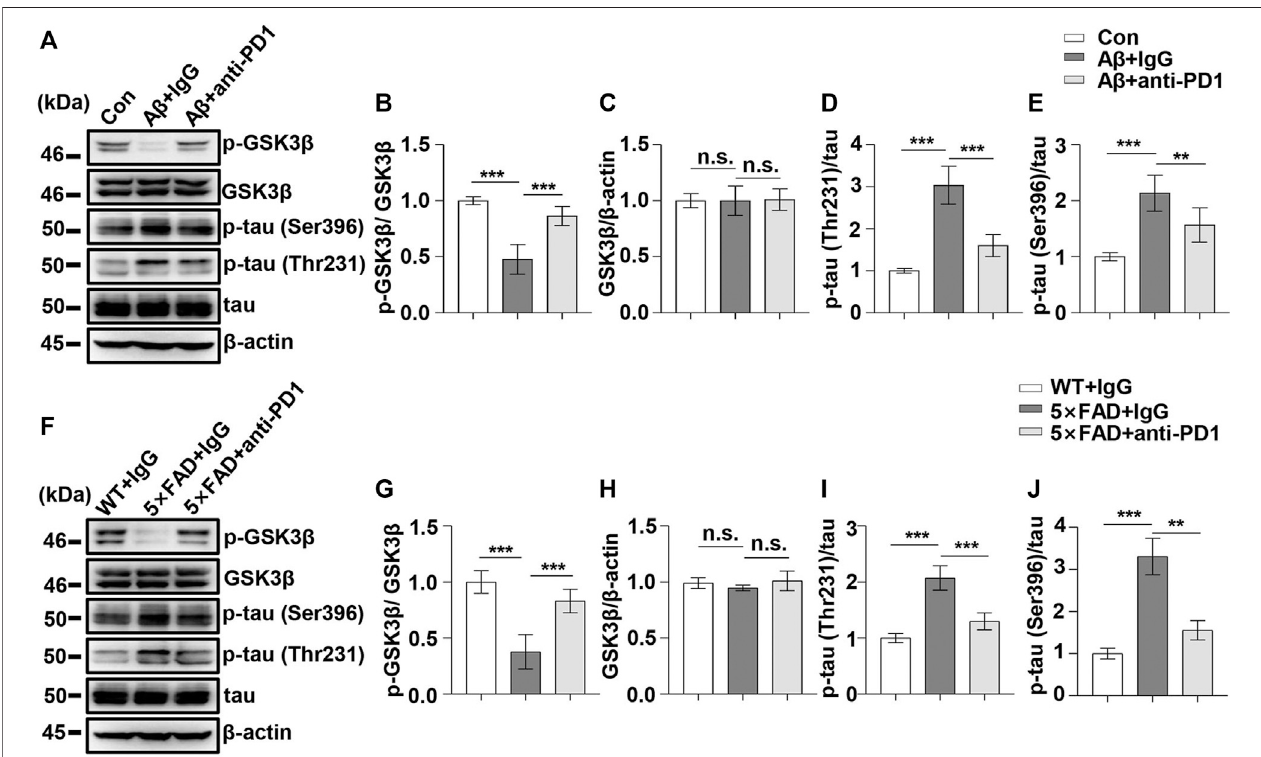
FIGURE5| PD1blockadereducedGSK3 β activityandtauhyperphosphorylationinADmousemodels.WTmice(C57BL/6,maleandfemale,aged2 – 3 months,n (cid:2) 10/group) were treated with A β 42, and then with anti-PD1 or control hamster IgG; after 12 days, the brain tissues were harvested. (A – E) PD1 blockade reduced GSK3 β activity and tau hyperphosphorylation. Hippocampal tissue lysates were subjected to western blotting with the anti- β -actin, anti-pGSK3 β (Ser9), anti-GSK3 β , anti-p-tau(Thr231),anti-p-tau(Ser396),andanti-tauantibodies(*** p < 0.001,** p < 0.01,one-wayANOVAfollowedbyDunnett ’ s post-hoc test).Male5 × FADmice (average age 9 – 10 months, n (cid:2) 10/group) were administered either anti-PD1 antibody or control hamster IgG. The brain tissues were harvested 1 month after MWM. (F – J) Hippocampaltissuelysatesweresubjectedtowesternblottingwiththeanti- β -actin,anti-pGSK3 β (Ser9),anti-GSK3 β ,anti-p-tau(Thr231),anti-p-tau(Ser396),and anti-tau antibodies (*** p < 0.001, ** p < 0.01, one-way ANOVA followed by Dunnett ’ s post-hoc test). n.s., p > 0.05. Data are representative of three independent experiments.